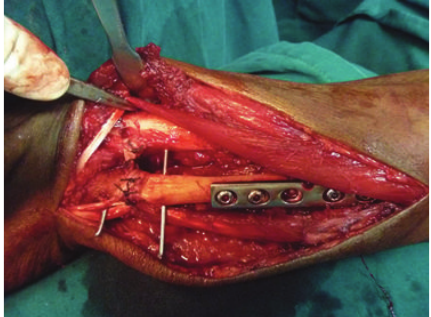
Figure 10: Harvested proximal fibula being trimmed.